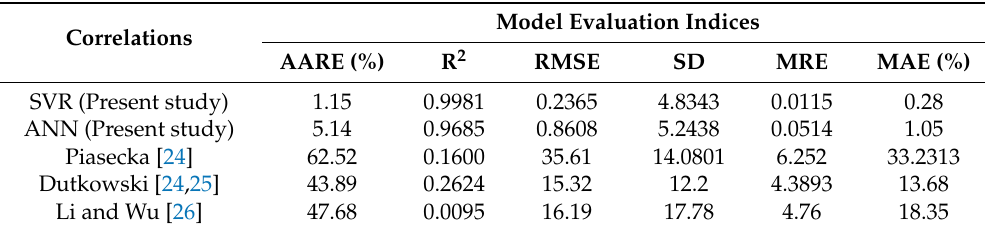
Table 5. Evaluation of the AI-based models versus existing correlations over the test dataset.